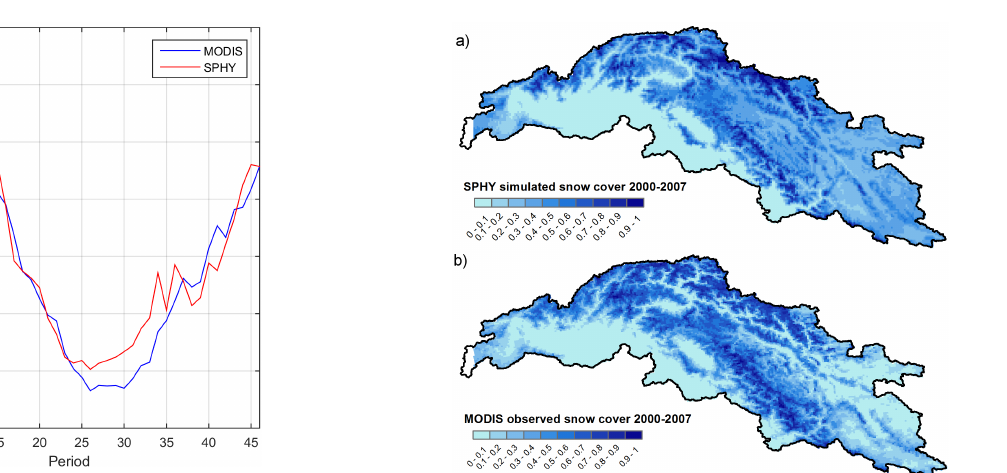
Figure 9. (a) SPHY simulated snow cover 2000–2007 and (b) MODIS observed snow cover